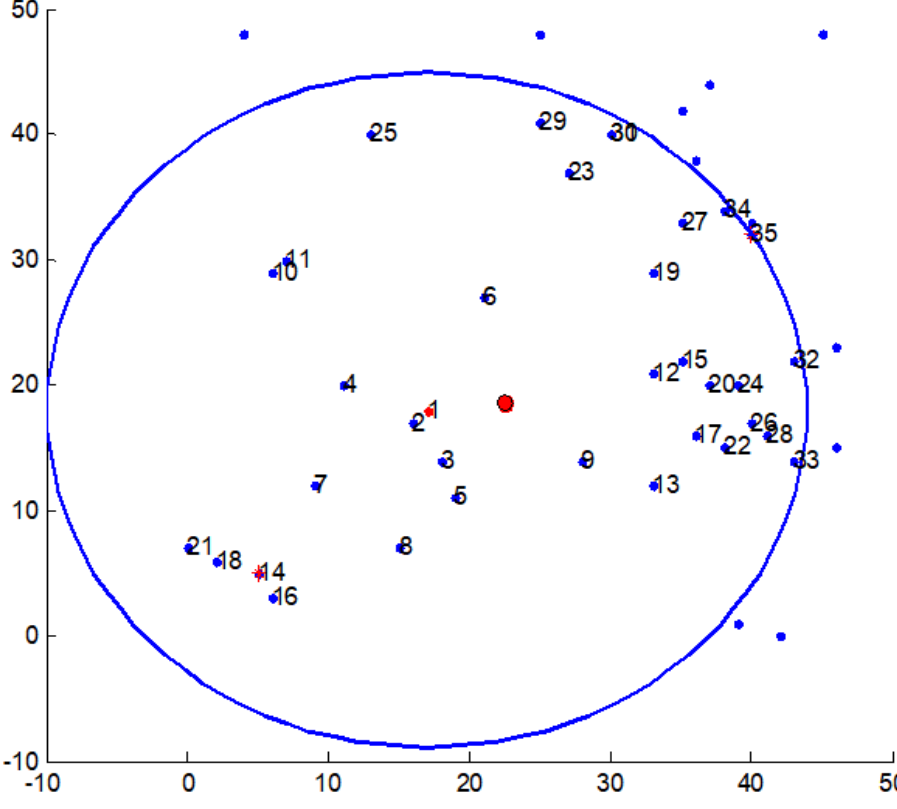
Figure 4. Search range for a distribution path.